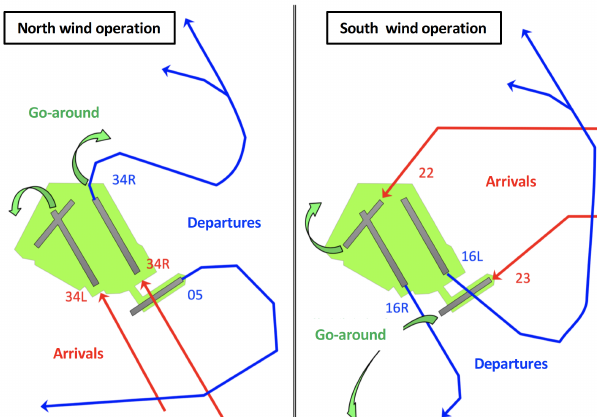
Figure 1. Departure and arrival operations at Tokyo International Airport depending on the wind